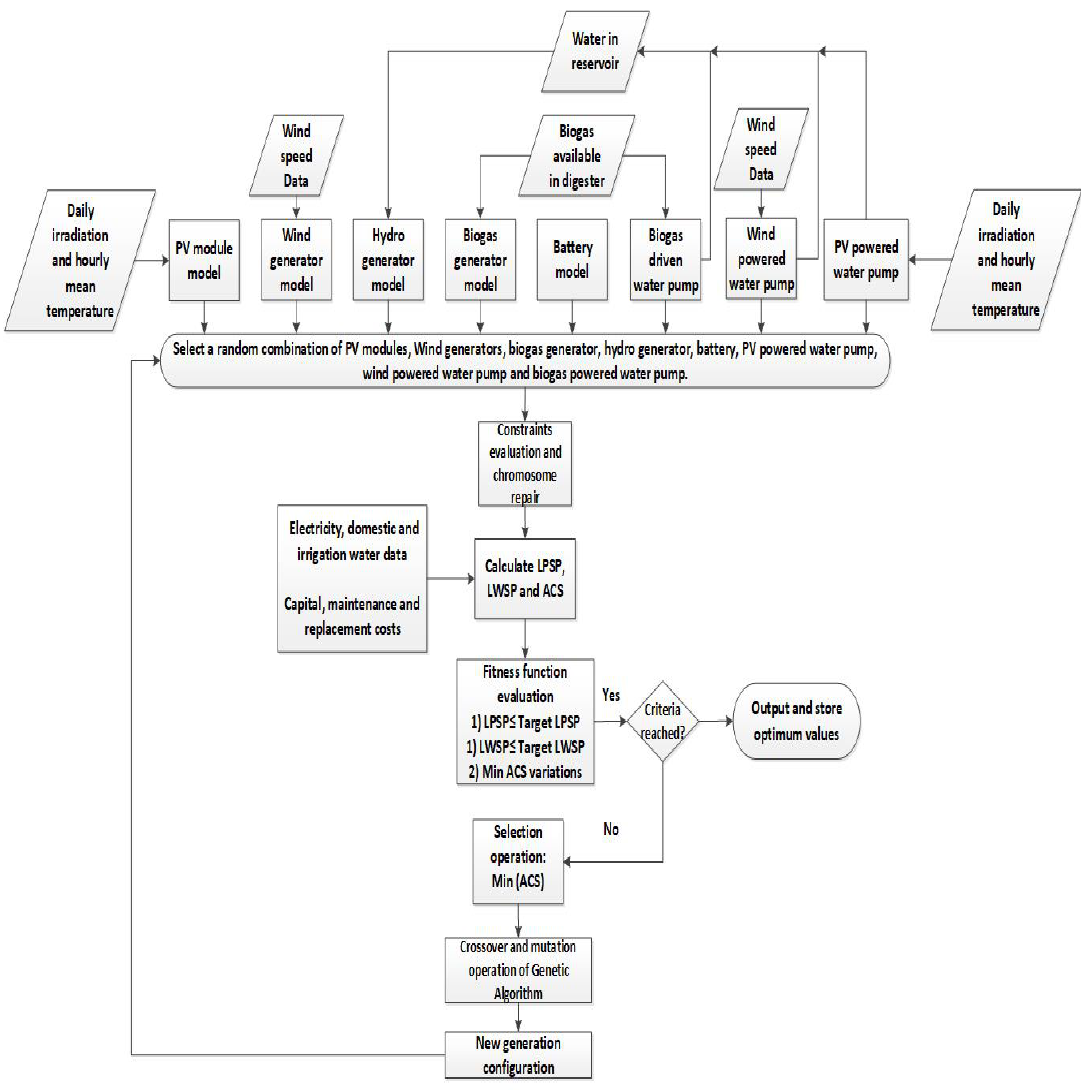
Figure 4. Flowchart for optimal sizing of SIRES using